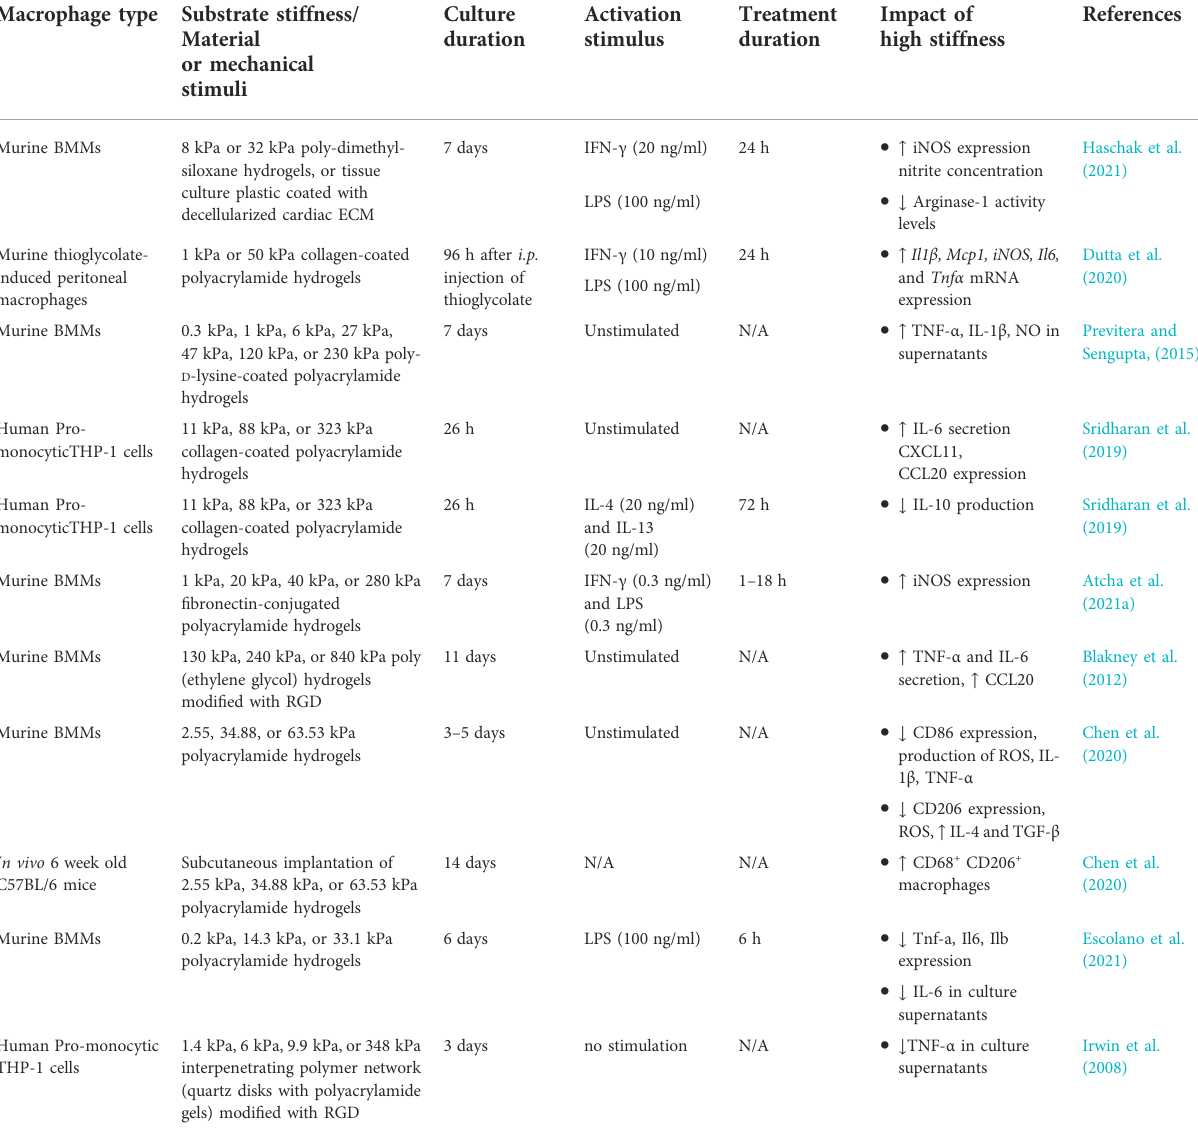
TABLE 2 Summary of effect of mechanical stimuli on the polarization of